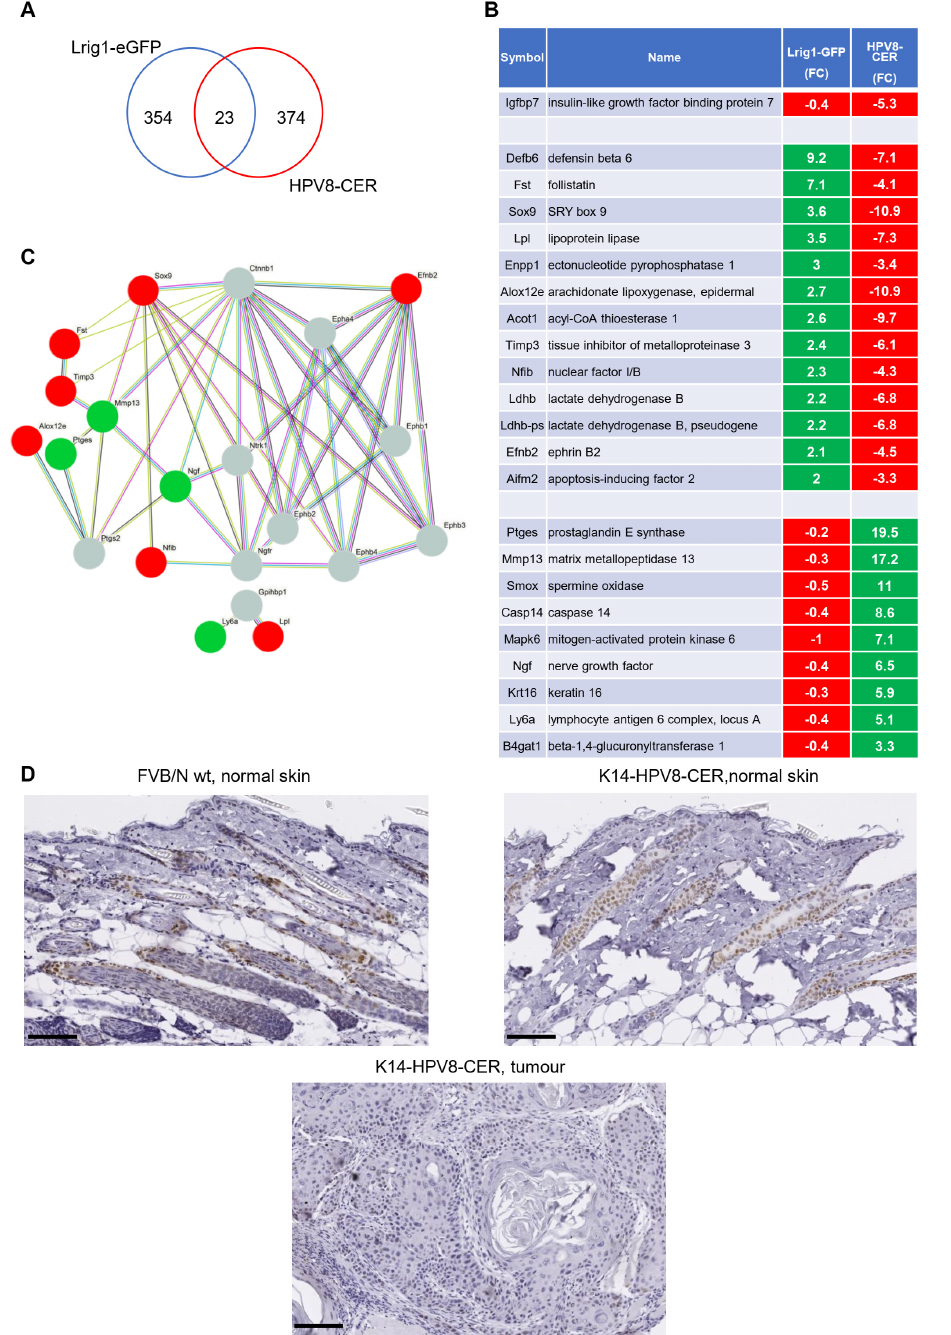
Figure 3. Comparison of DEGs differentially expressed in K14-HPV8-CER and Lrig1-EGFP-ires- CreERT2 mice. ( A ) Venn diagram showing the overlap of DEGs found in skin tumours of K14-HPV8-CER and the skin of Lrig1-EGFP-ires-CreERT2 mice. ( B ) Heat map of 23 genes identified by Venn analysis (green: upregulated genes, red: downregulated genes). ( C ) The protein–protein interaction (PPI) network plot for the 23 genes using STRING database (code colour: green, upregulated; red, downregulated; grey, database predicted interactors). Line colour indicates the type of interaction evidence e.g., known interaction, or predicted interaction. ( D ) Representative immunohistochemical staining for SOX9 in FVB/N wild-type, K14-HPV8-CER non-lesional skin as well as K14-HPV8-CER skin tumour. Staining revealed strong expression in FVB/N wild-type and non-lesional K14-HPV8- CER skin. SOX9 was found to be almost completely absent in K14-HPV8-CER tumours (scale bar: 100 µ